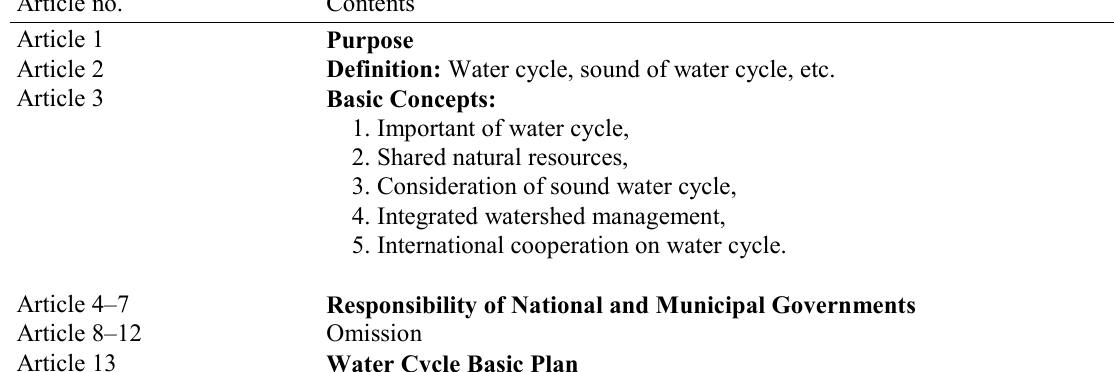
Table 2 Summary of Article contents of the Water Cycle Basic Law under planning in Japan.